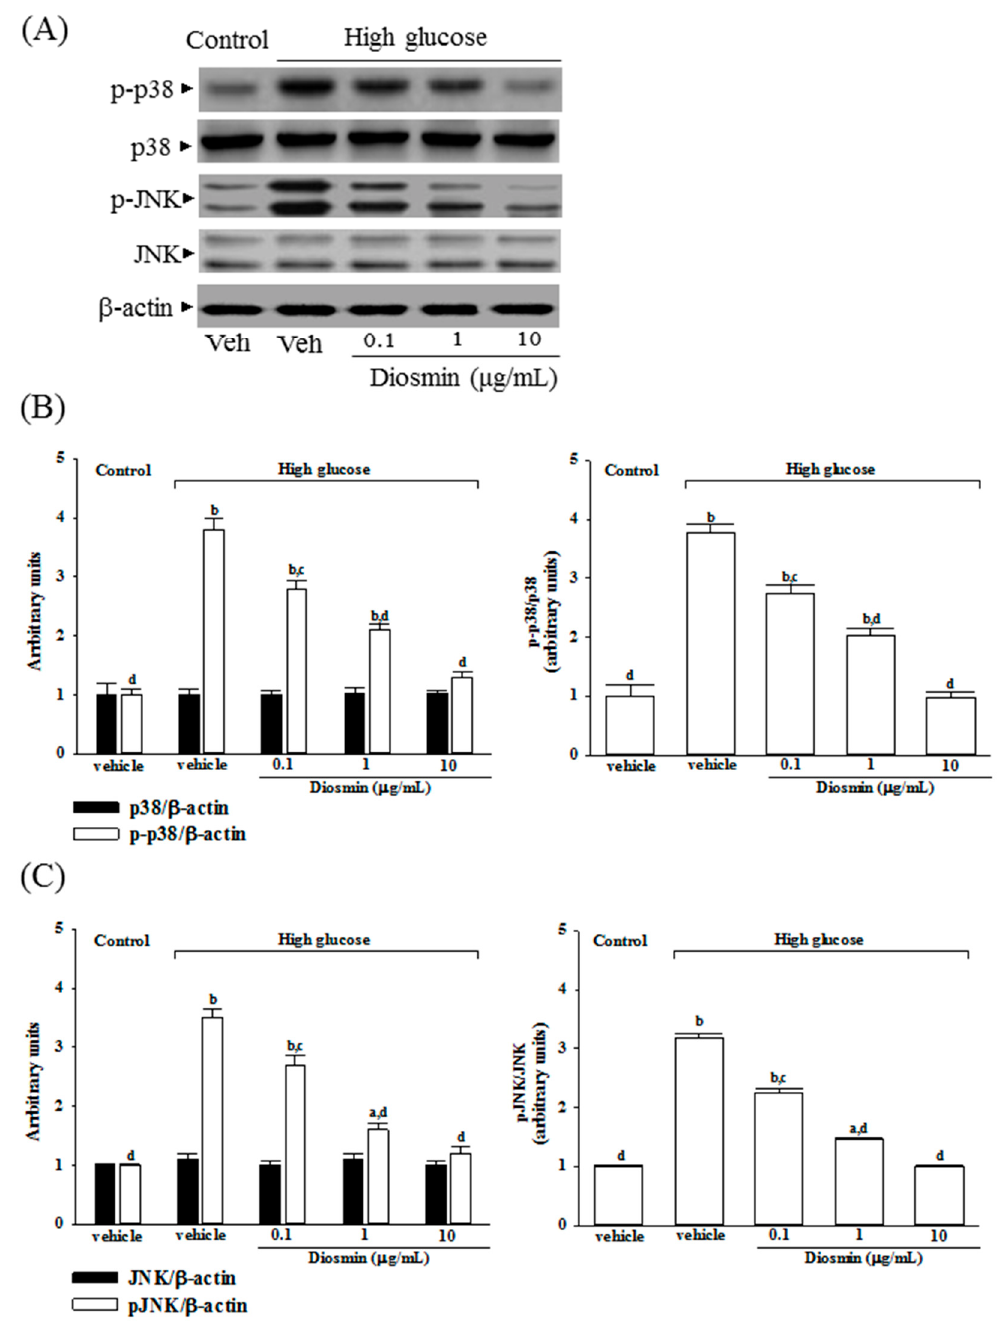
Figure 5. Effect of diosmin on p38 and JNK activation in high glucose cultured ARPE-19 cells. ( A ) The photographs were representatives the western blots for p-p38, p38, p-JNK, JNK and β -actin. Five western blots per group were experimented; ( B ) The relative intensities of phosphorylated and total p38 protein (fold to β -actin) were determined and the p-p38/p38 ratio was calculated; ( C ) The relative intensities of phosphorylated and total JNK protein (fold to β -actin) was determined and the p-JNK/JNK ratio was calculated. Each column represents means ± SD ( n = 5 per group). a p < 0.05 and b p < 0.01 compared with normal-glucose vehicle-treated group (control), respectively. c p < 0.05 and d p < 0.01 compared with high-glucose vehicle-treated group, respectively.